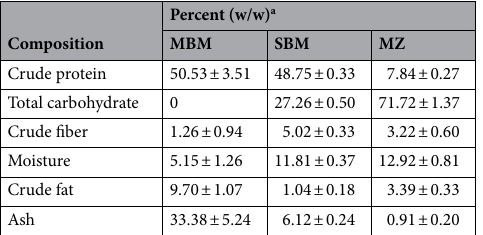
Table 1. Proximate analysis of feed ingredients. a Mean ± S.D. of three